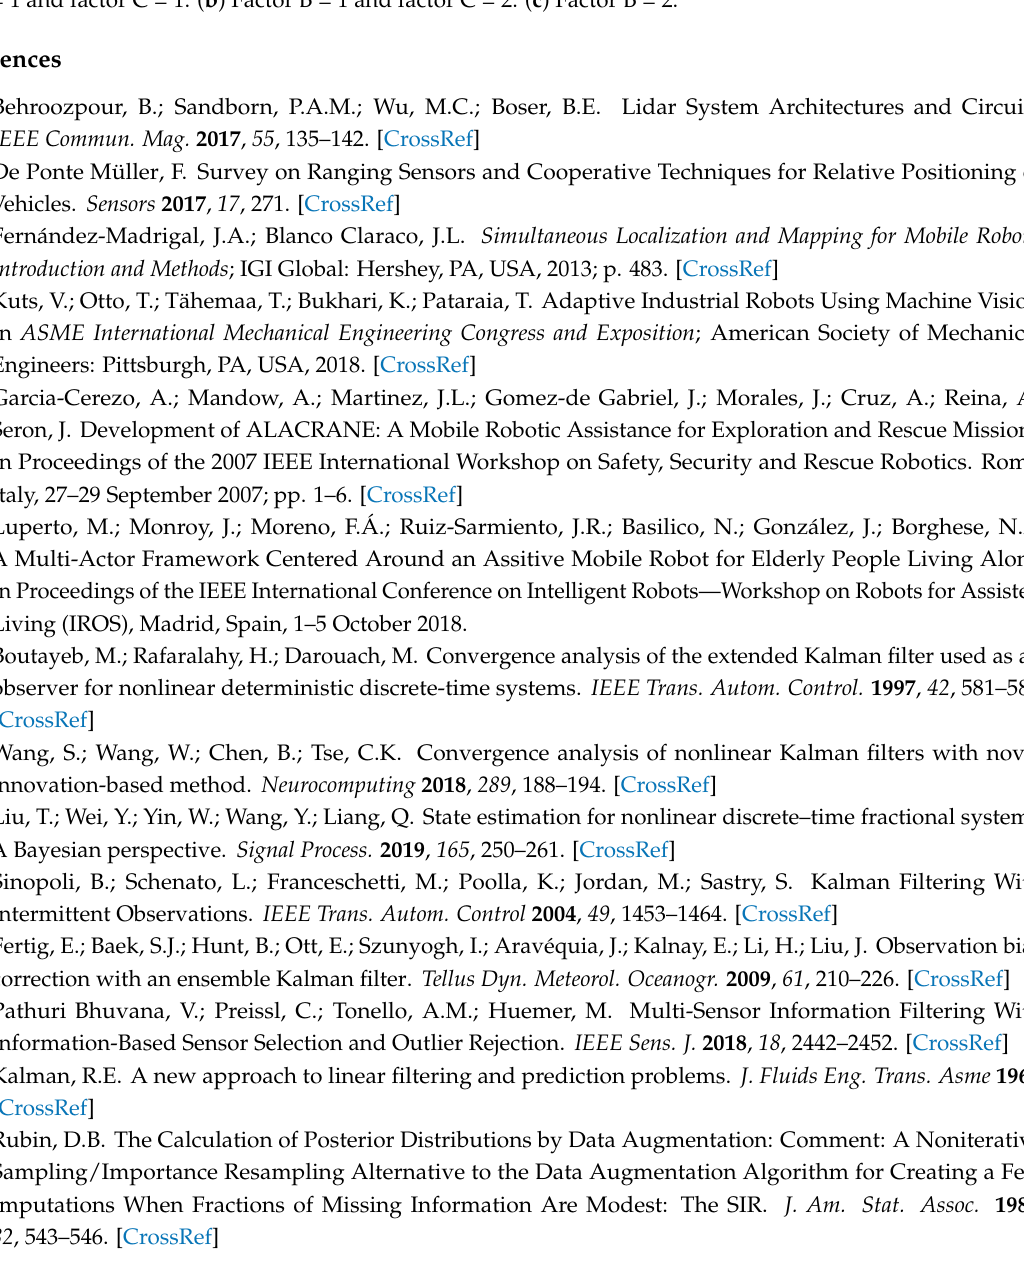
Figure A35. Histograms for the conclusions about the effect of factor D on the convergence performance, represented for the two levels of such factor with additional restrictions on the population. ( a ) Factor B = 1 and factor C = 1. ( b ) Factor B = 1 and factor C = 2. ( c ) Factor B =